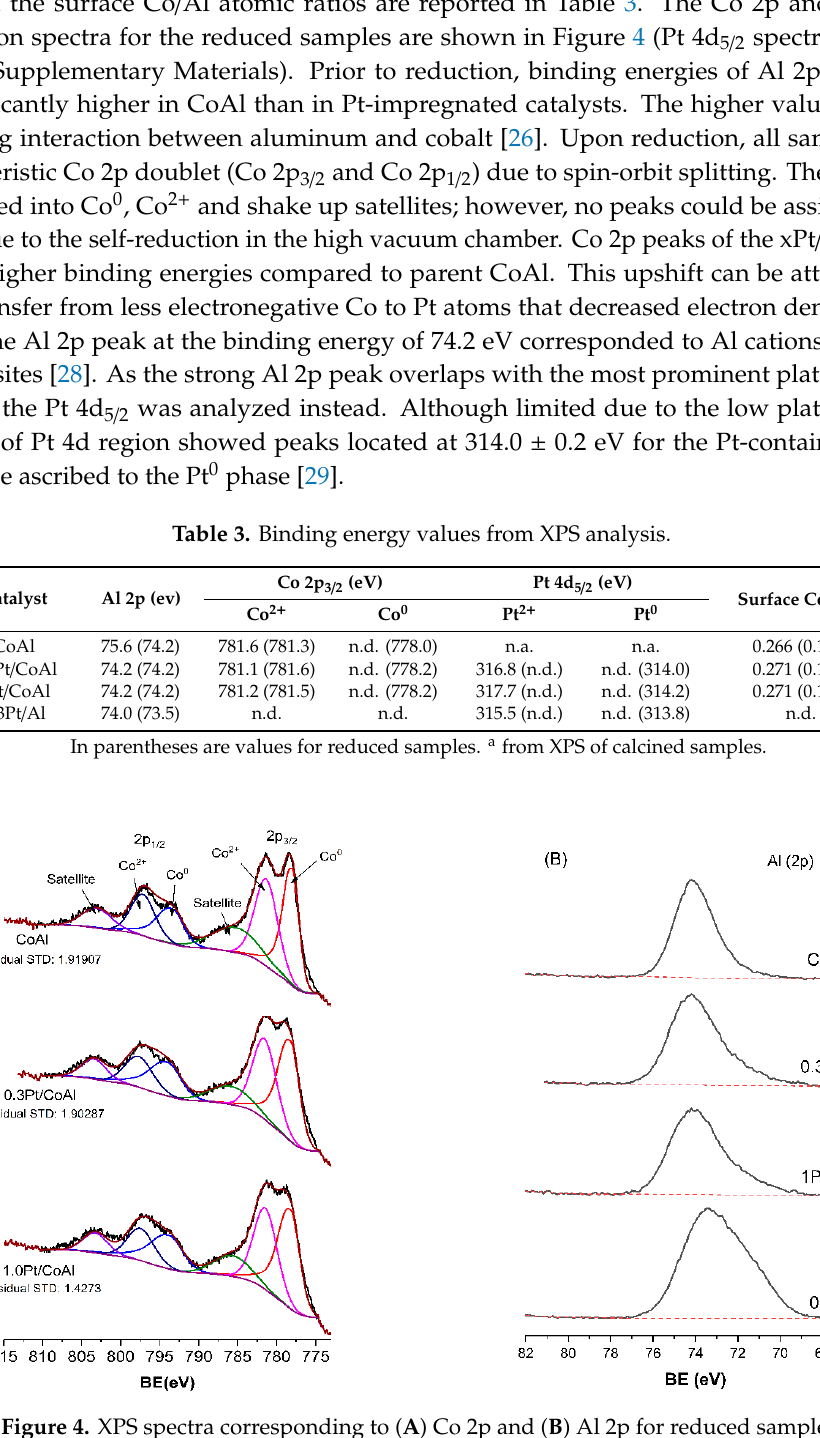
Figure 4. XPS spectra corresponding to ( A ) Co 2p and ( B ) Al 2p for reduced samples.